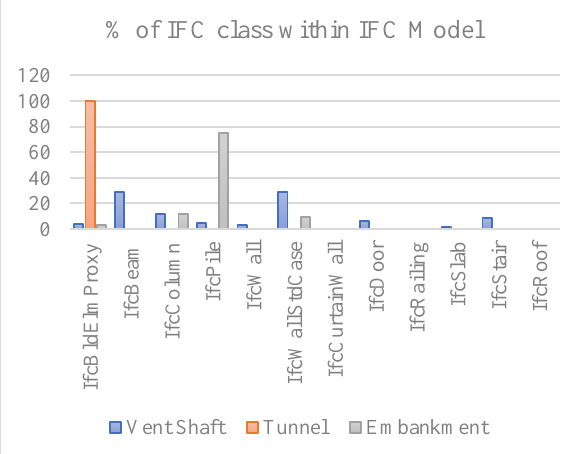
Figure 6: Calculation of % of IFC Class within every IFC Model for Vent Shaft, Tunnel and